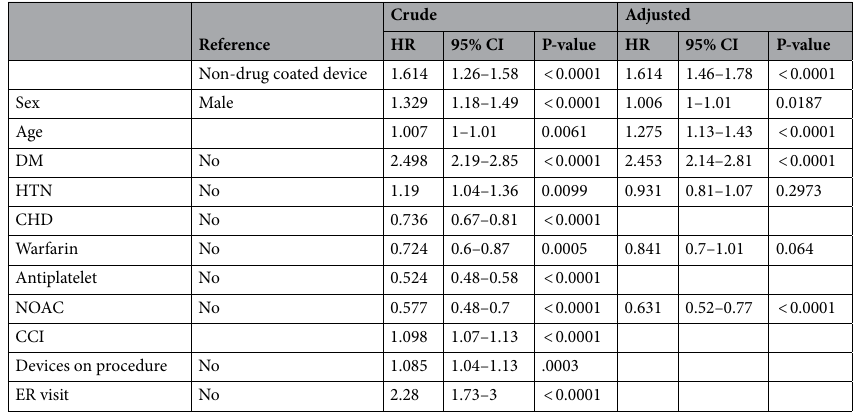
Table 3. Univariate and multivariate analysis of amputation free survival after propensity score matching. DM diabetes mellitus, HTN hypertension, CHD coronary heart disease, NOAC new oral anticoagulants, CCI charlson comorbidity index, HR hazard ratio, ER emergency